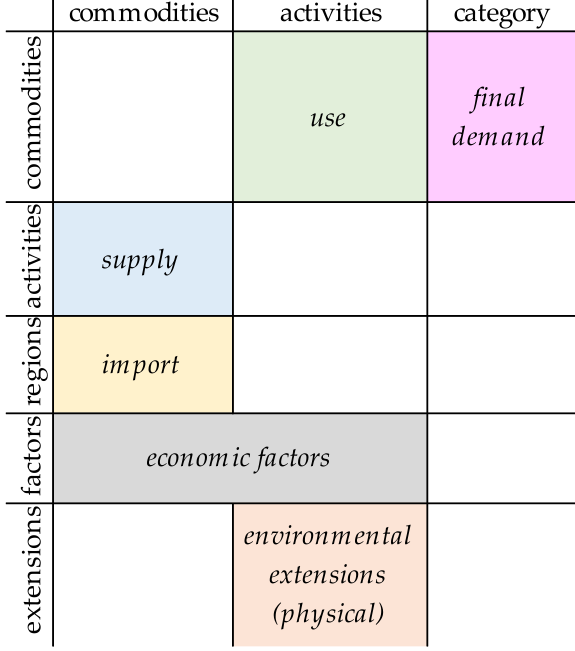
Table 1. Input parameters for shading tree management intervention.